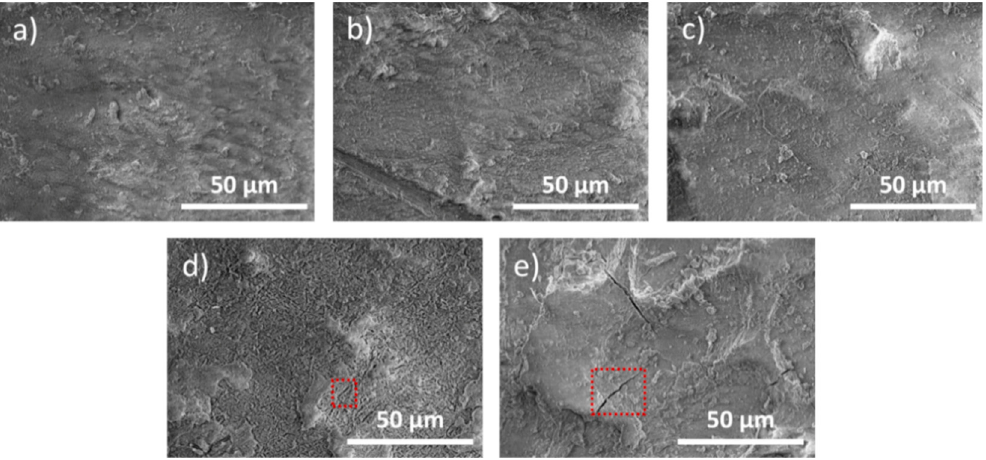
Figure 8. Morphology views of Mung beans: ( a ) Initial, ( b ) 10 min, ( c ) 30 min, ( d ) 60 min, ( e ) 90 min of the plasma treatment. Red dots—appeared cracks.